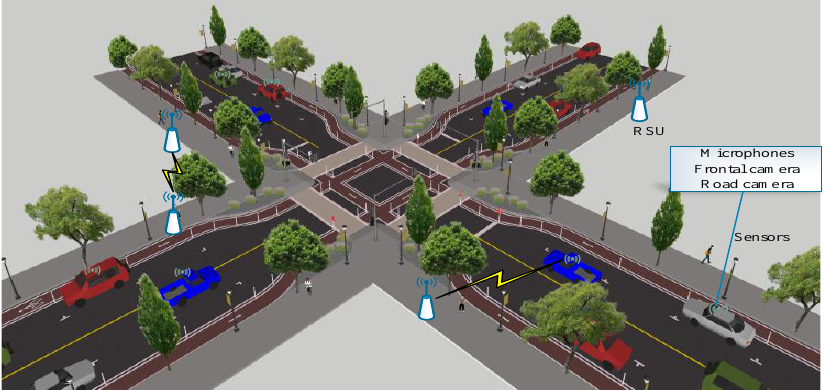
Figure 1. Environment of driver behavior analysis.